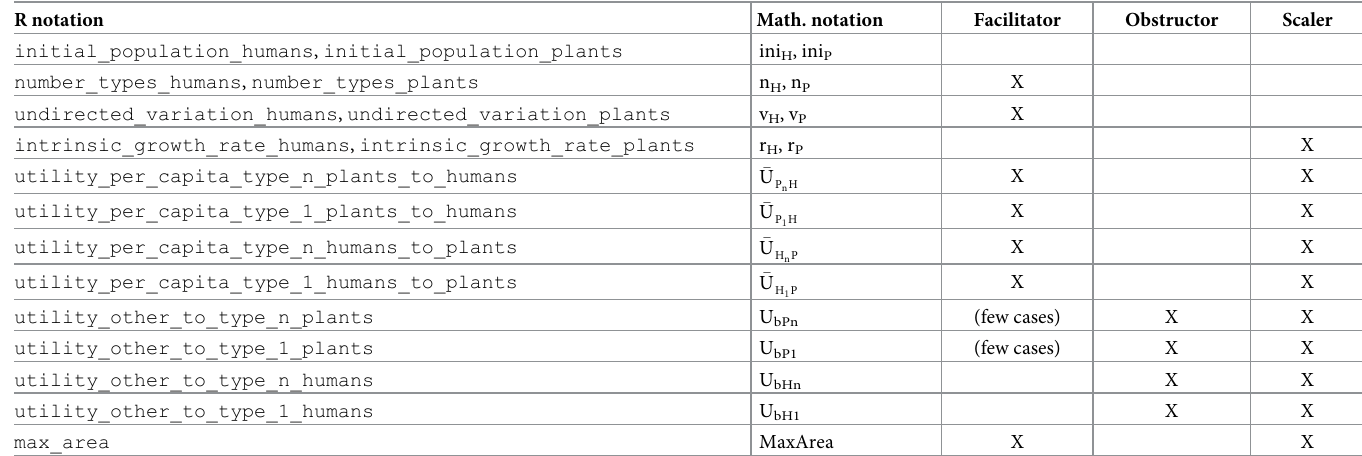
Table 6. Parameter